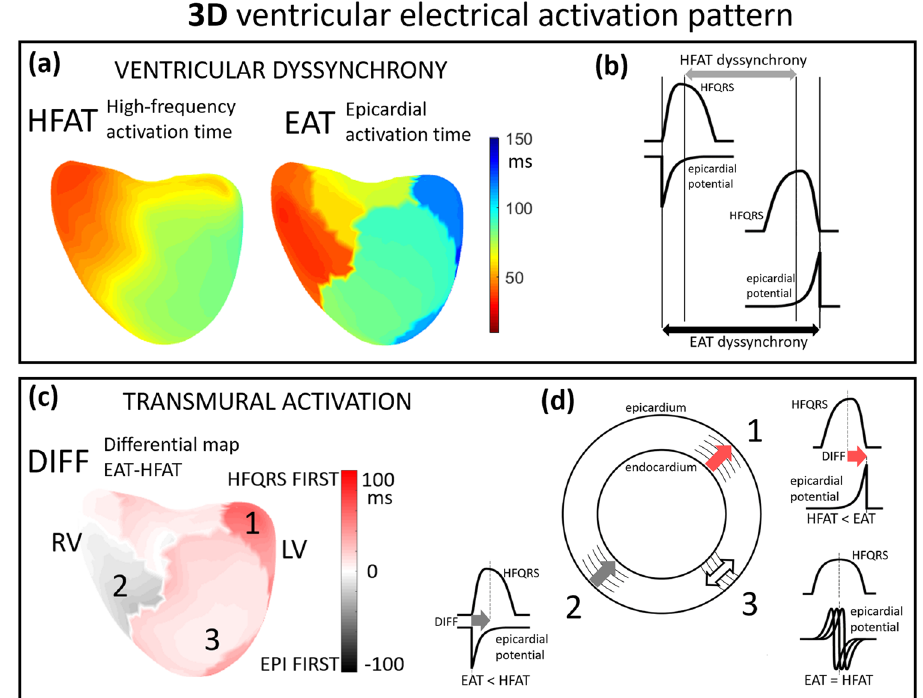
Figure 8. Interpretation of difference between ECGI and HFECGI-derived activation times. ( a ) High- frequency activation time (HFAT) and epicardial activation time (EAT) maps (anterior view) of patient #3 (LBBB). The red color indicates earlier activation, and the blue color indicates later activation. ( b ) Schematic representation of ventricular dyssynchrony based on EAT and HFAT. ( c ) DIFF map; red tones indicate EAT > HFAT and gray tones HFAT > EAT. ( d ) Interpretation of DIFF values. In area 1 HFAT is smaller (sooner) than EAT (marked by red arrow), representing a dominant propagation directed from the endocardium to the epicardium. In area 2 the prevailing direction of propagation is opposite because EAT precedes HFAT (marked by the gray arrow). In areas with similar EAT and HFAT values (area 3), the dominant direction of propagation is along the wall, or there are turbulences in depolarization